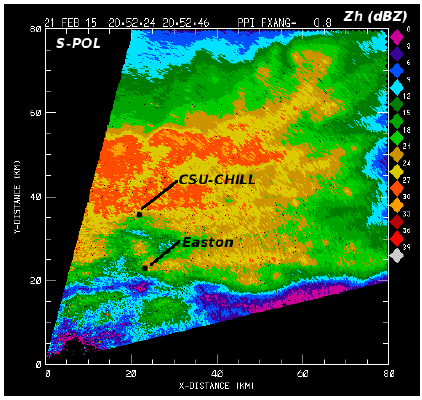
Figure 24. SPOL radar reflectivity data collected in a 0.8° plan position indicator (PPI) scan as a major snow band arrived at the CSU-CHILL radar site at 20:51 UTC on 21 February 2015. Axes are in km from SPOL.